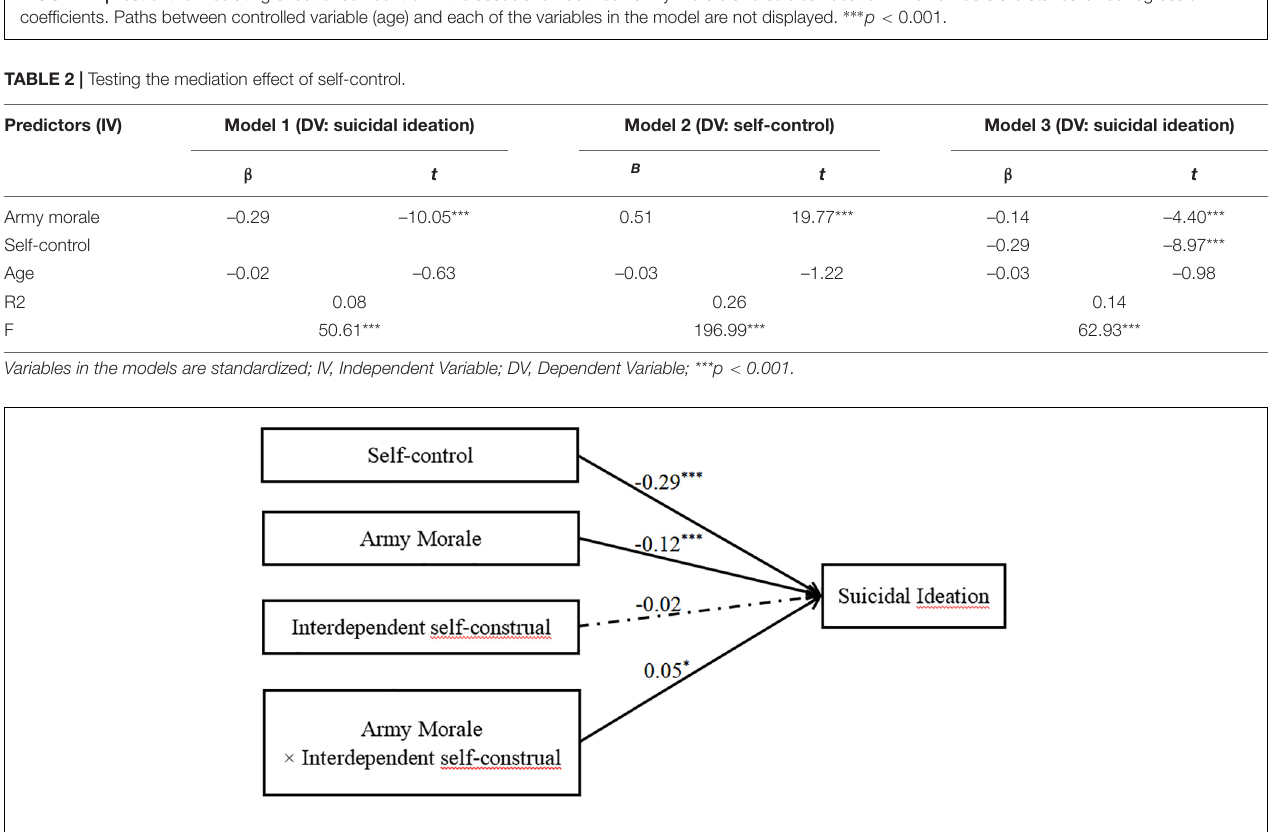
FIGURE 2 | Test of the mediating effect of self-control in the association between army morale and suicidal ideation. The numbers are standardized regression coefficients. Paths between controlled variable (age) and each of the variables in the model are not displayed. ∗∗∗ p < 0.001.